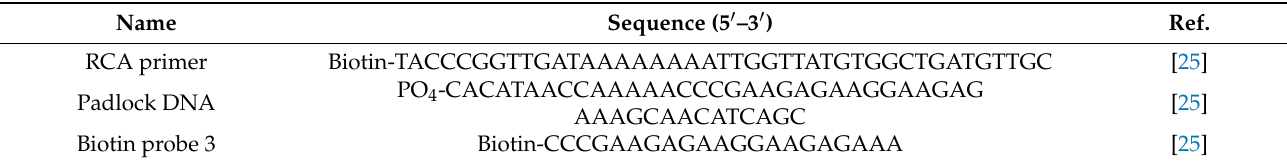
Table 1. The sequences of primers and